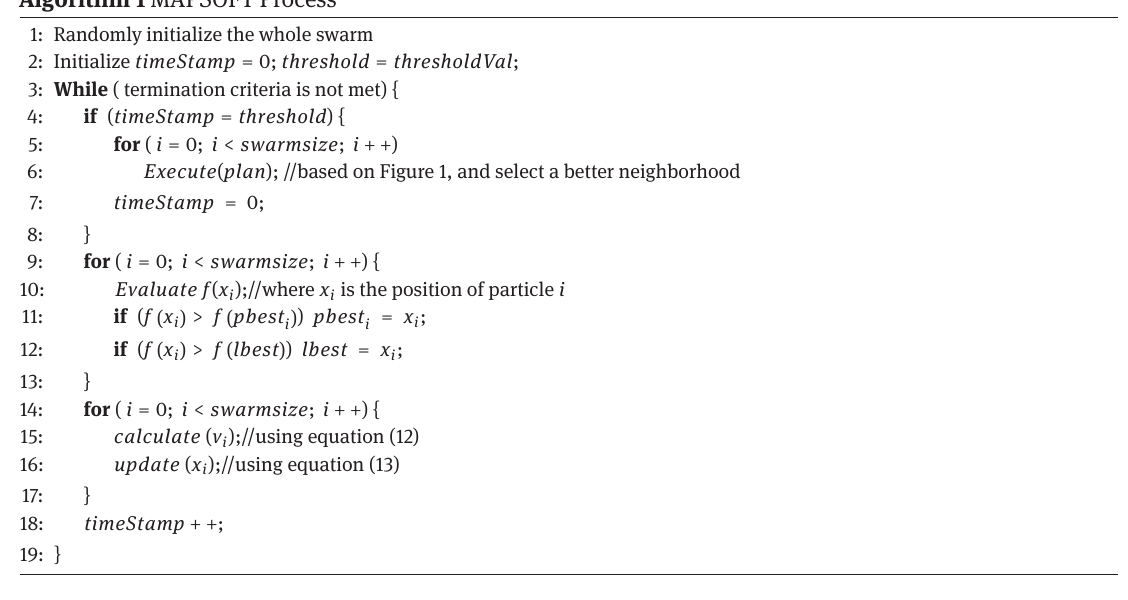
Algorithm 1 MAPSOFT